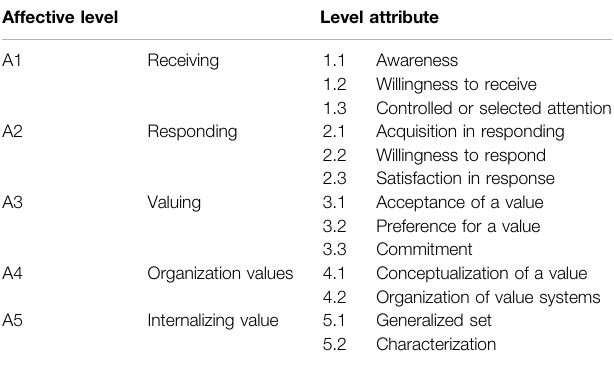
TABLE 3 | Levels of the affective domain (Krathwohl ’ s